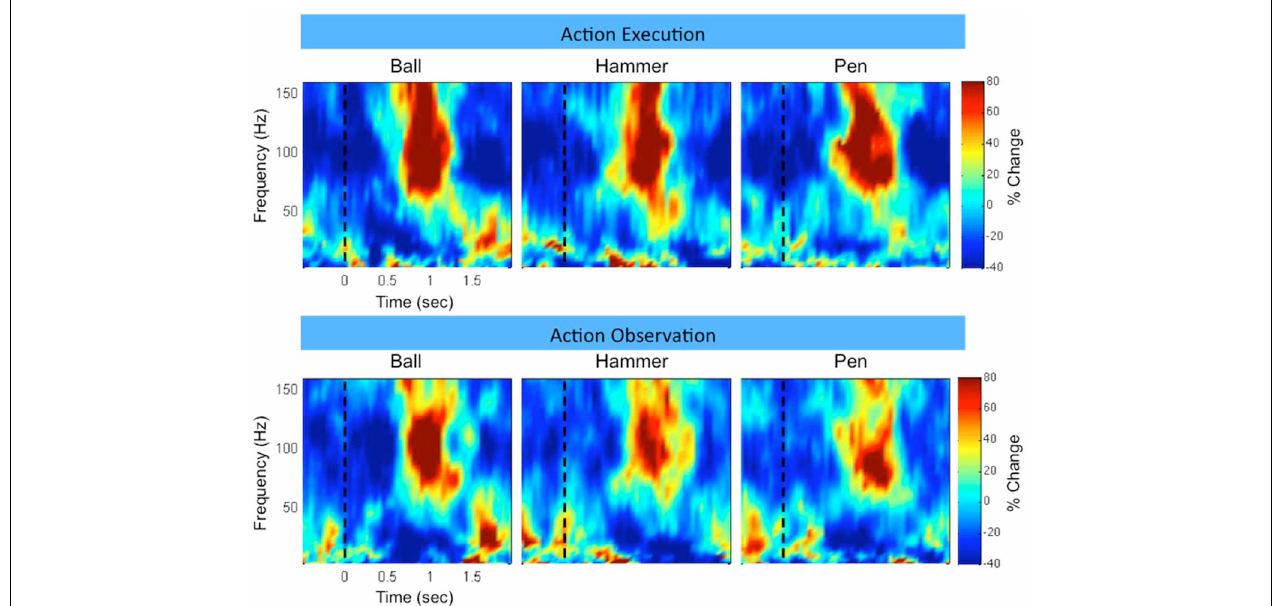
FIGURE 3 | Example neural activity during action execution (AE) and observation (AO). Example time-frequency plot of neural activity (Subject F, high-density ECoG grid electrode #7) during AE and AO of three grasping tasks (Ball, Hammer, Pen). The color indicates normalized spectral power expressed